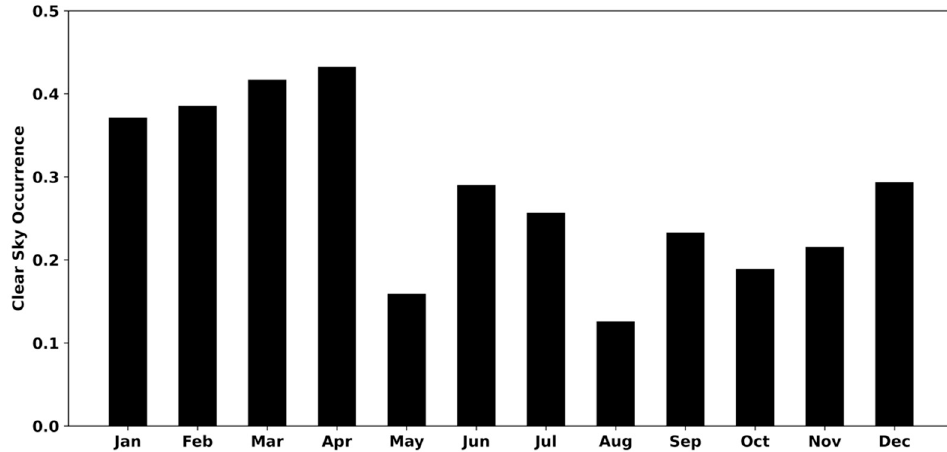
Figure 5. Monthly-mean clear sky occurrences of frequency at the NSA site.